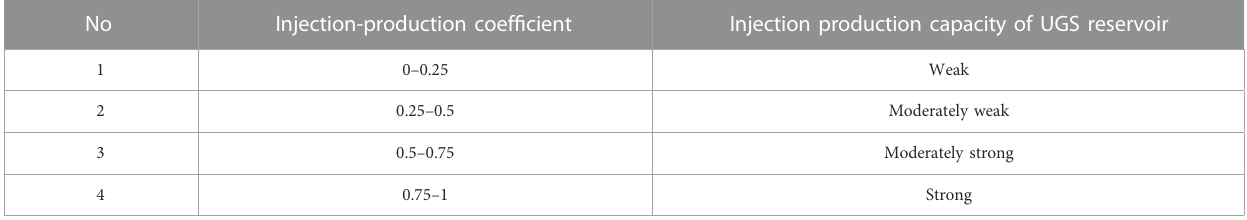
TABLE 3 Evaluation standard for injection production capacity of